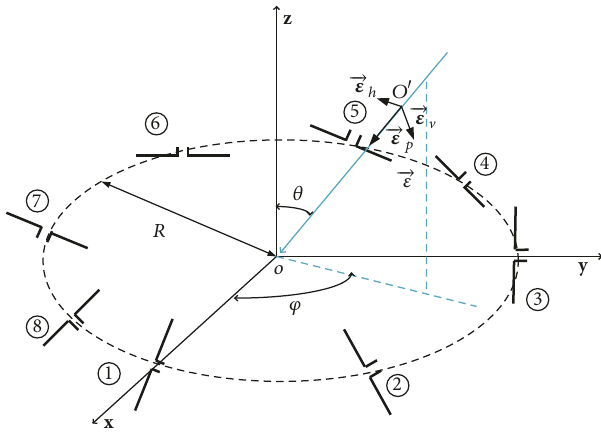
Figure 1: The geometry of the circular